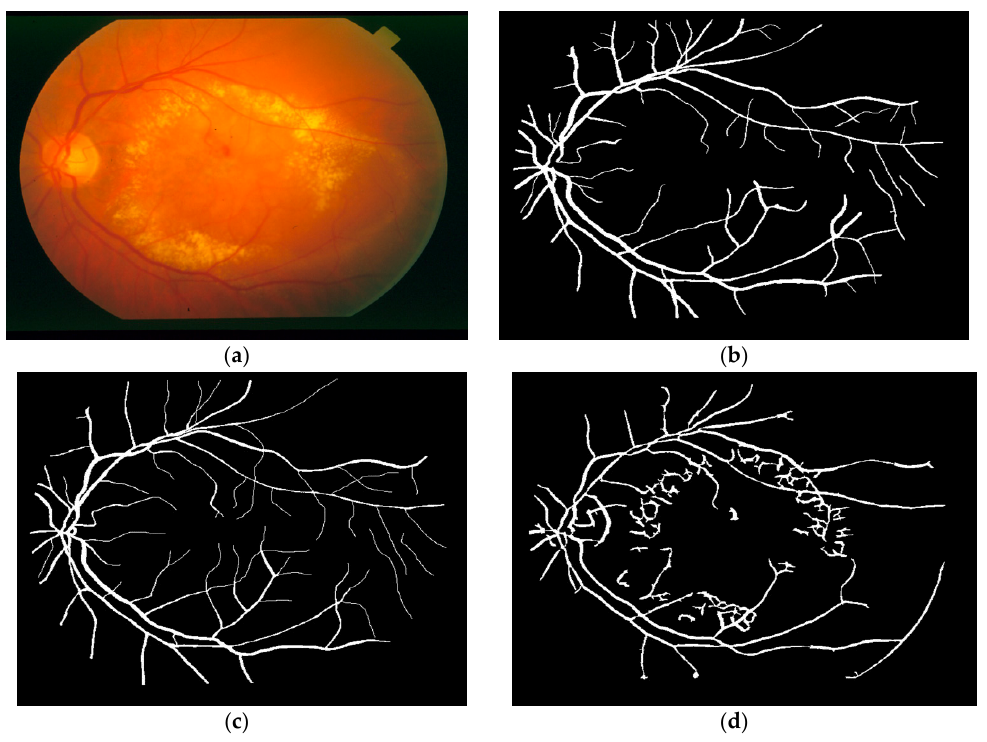
Figure 2. Example of a fundus image used: ( a ) Example of a raw image im0002.jpg; ( b ) Vessel networks marked by hand provided by Adam Hoover; ( c ) Vessel networks marked by hand provided by Valentina Kuznetsova; ( d ) Vessel networks produced by matched spatial filter probing algorithm.